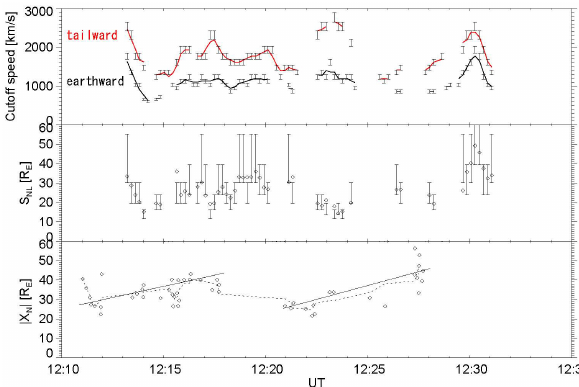
Fig. 6. (a) Time histories of lower-energy cutoffs, (b) estimated distance from the Geotail to the beam source, (c) estimated beam source location against the event